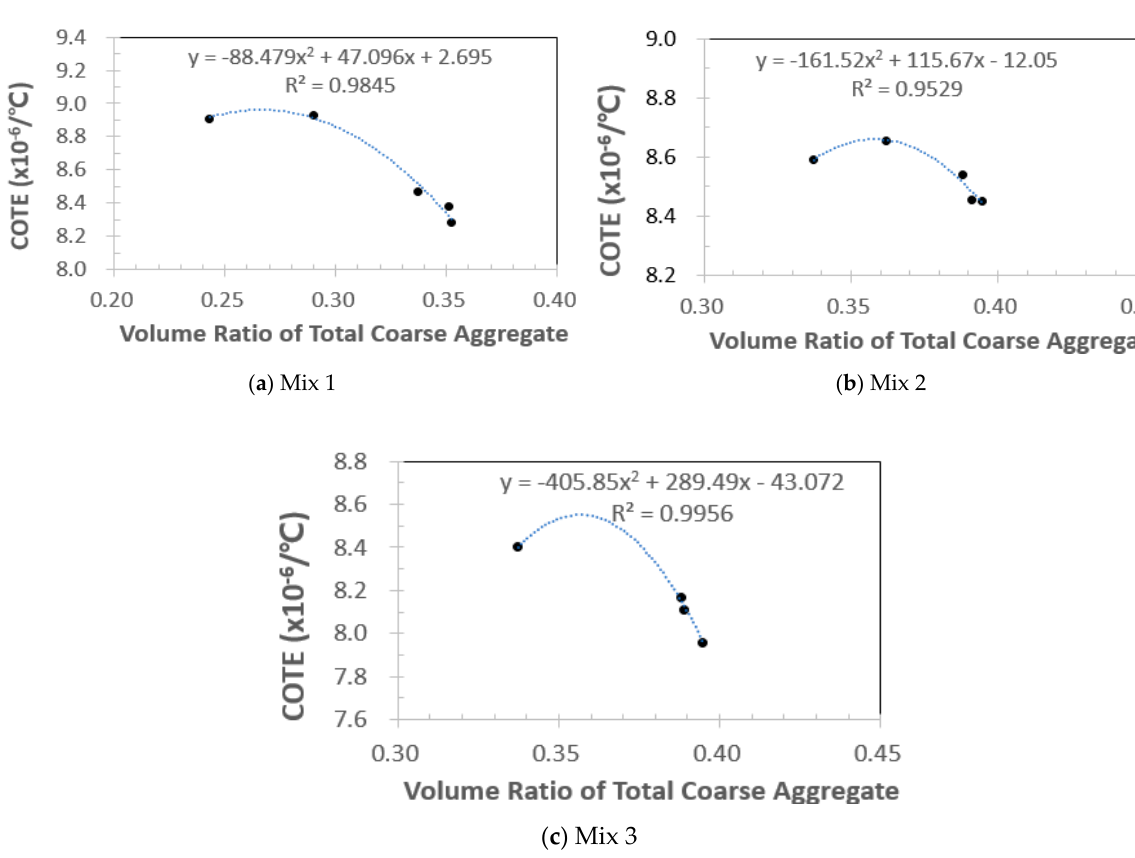
Figure 9. COTE values in terms of total coarse aggregate volume ratio.